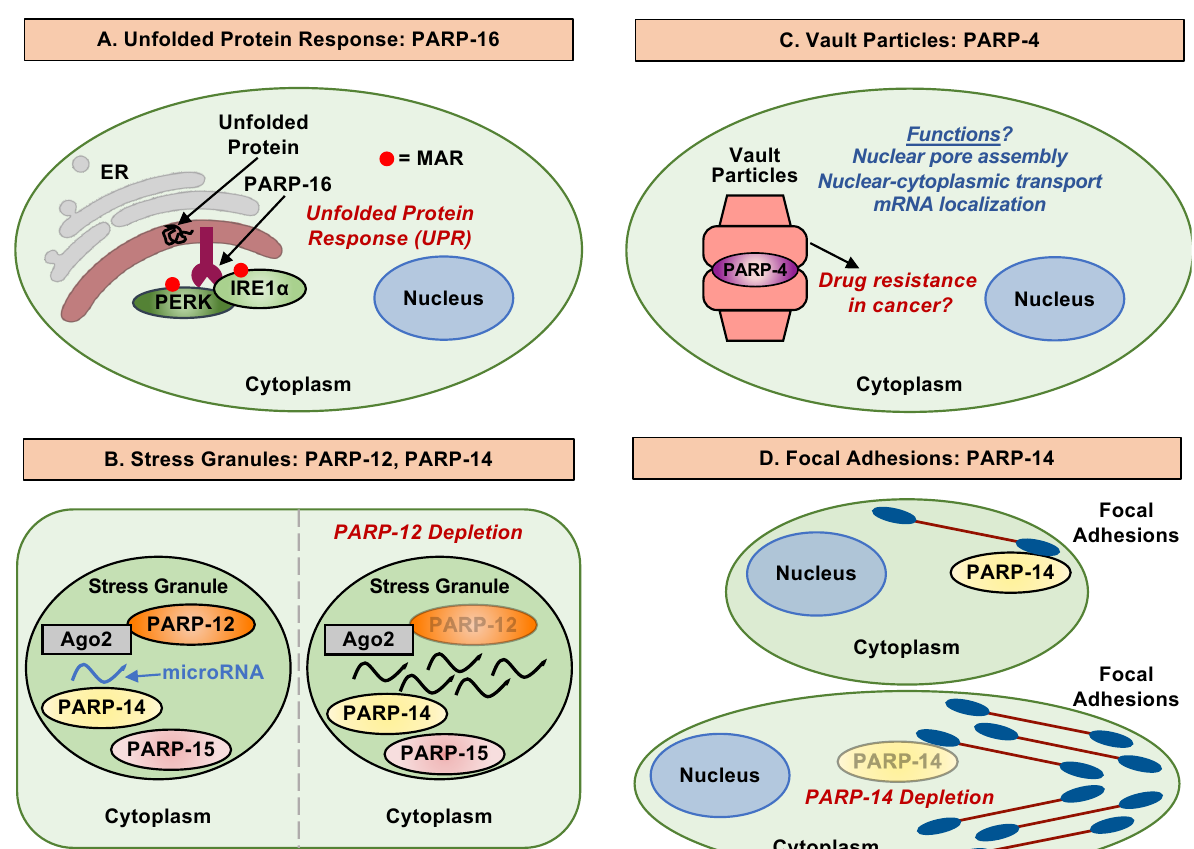
Figure 4. Biological processes regulated by cytosolic MARTs. ( A ) PARP-16 regulates the unfolded protein response (UPR) by modulating the activity of PERK and IRE1 α through MARylation. ( B ) PARP-12, PARP-14, and PARP-15 are components of stress granules. PARP-12 associates with Ago2; upon PARP-12 depletion, microRNA levels increase. ( C ) PARP-4 is a component of vault particles, which are thought to play important roles in drug resistance in cancers. ( D ) PARP-14 is a component of focal adhesion complexes and is required for proper focal adhesion function and disassembly, as well as cell